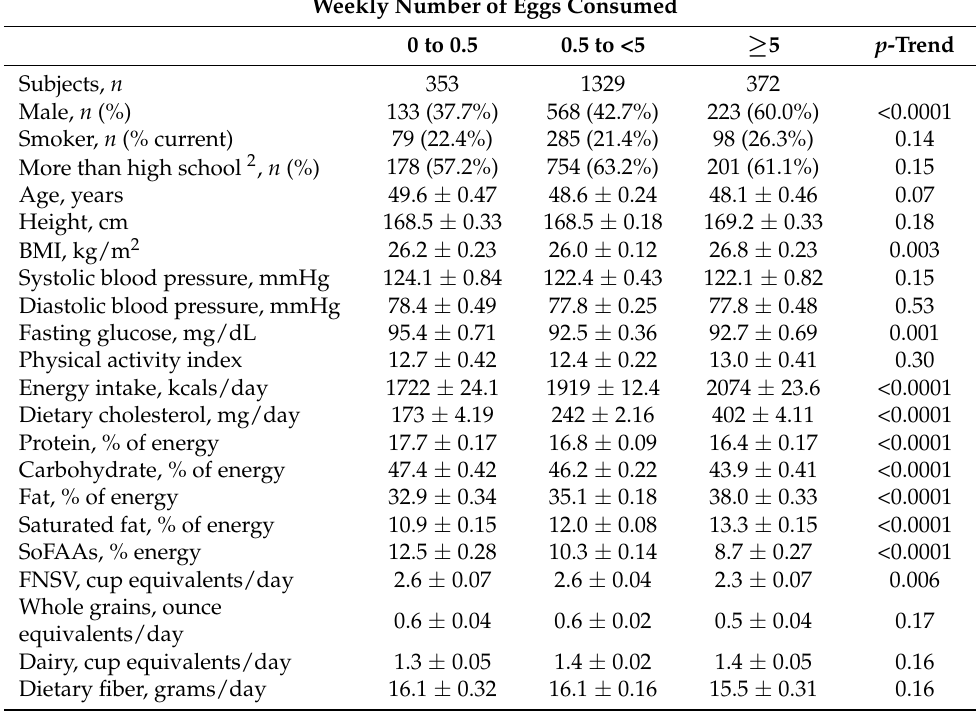
Table 1. Baseline characteristics of subjects in the Framingham Offspring Study according to egg consumption 1 .